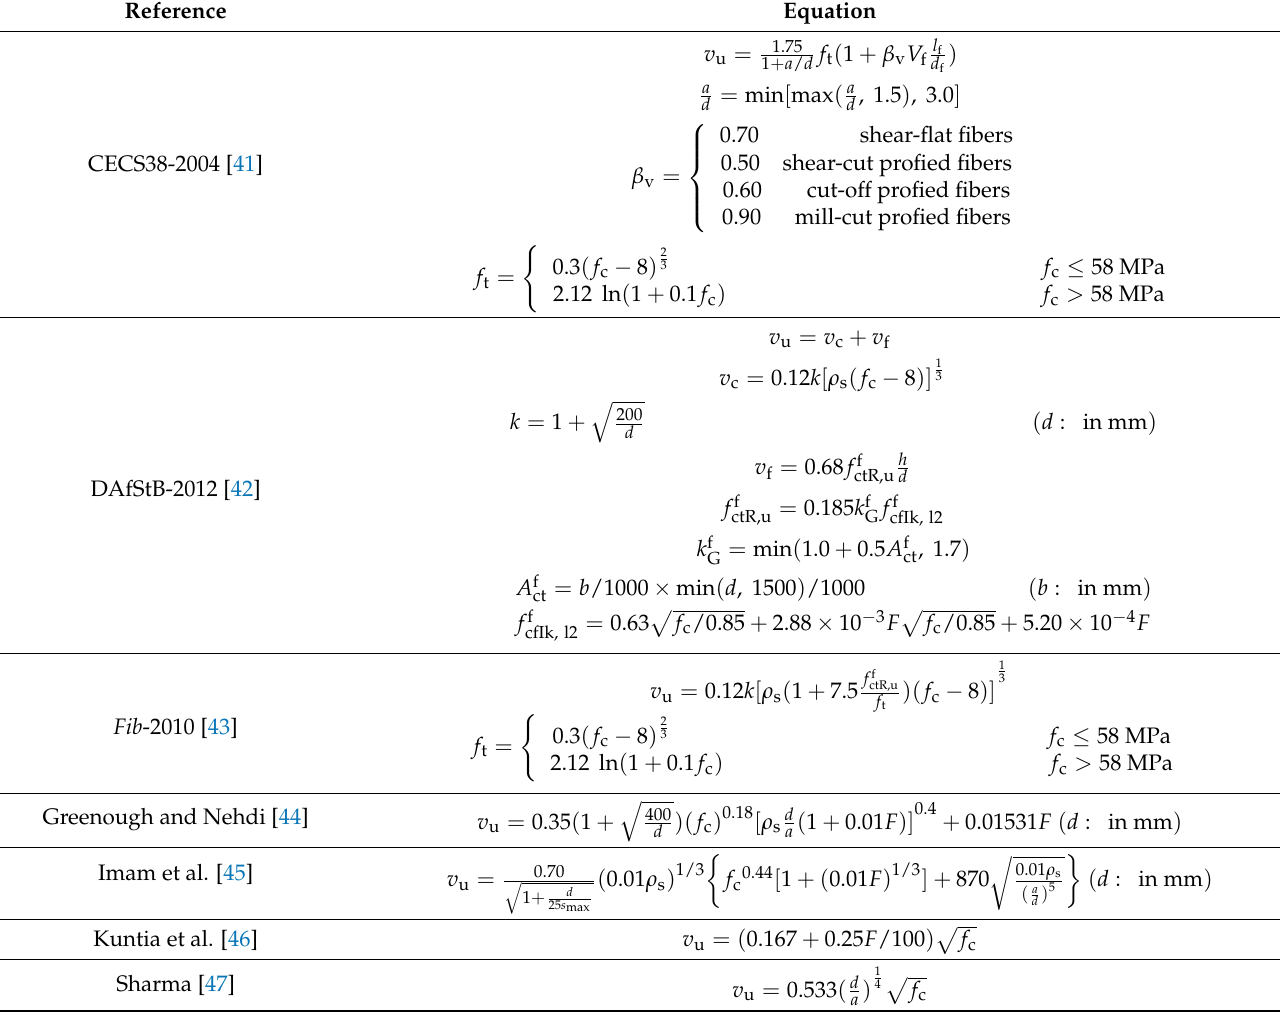
Table 2. Empirical shear strength models for SFRC beams without